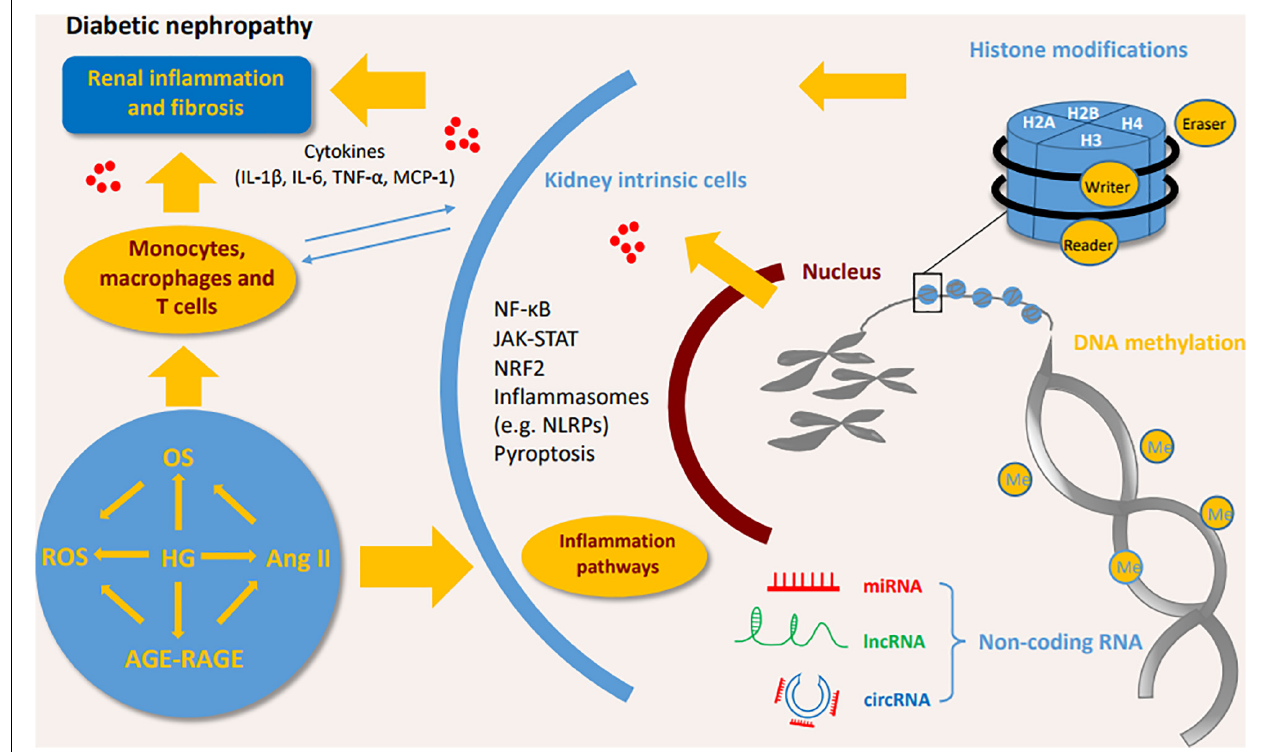
FIGURE 2 | The inflammatory pathways involved in the DN process. High glucose or stimulating factors cause the activation of multiple pathways, including P38/MAPK, PI3K/AKT, TLR4/NLRP3 and the novel CRP/DPP4/CD32b, which all further activate NF- κ B pathway, and transcriptionally promote the expression of multiple inflammatory cytokines to enhance inflammation. SMAD7 can inhibit NF- κ B activity. NRF2 has anti-inflammatory and antioxidant functions in DN. In addition, JAK/STAT pathway induces IL-6 to promote the inflammatory response in DN. DN, diabetic nephropathy; IL, interleukin; TNF, tumor necrosis factor; NF- κ B, Nuclear factor- κ B; MCP-1, monocyte chemoattractant protein-1; STAT, Signal transducer and activator of transcription; NRF2, Nuclear factor-2 erythroid related factor; NLRP3, NOD-like receptor protein 3; ROS, reactive oxygen species; DPP4, dipeptidyl peptidase-4; MAPK, mitogen-activated protein kinase; JAK2, Janus